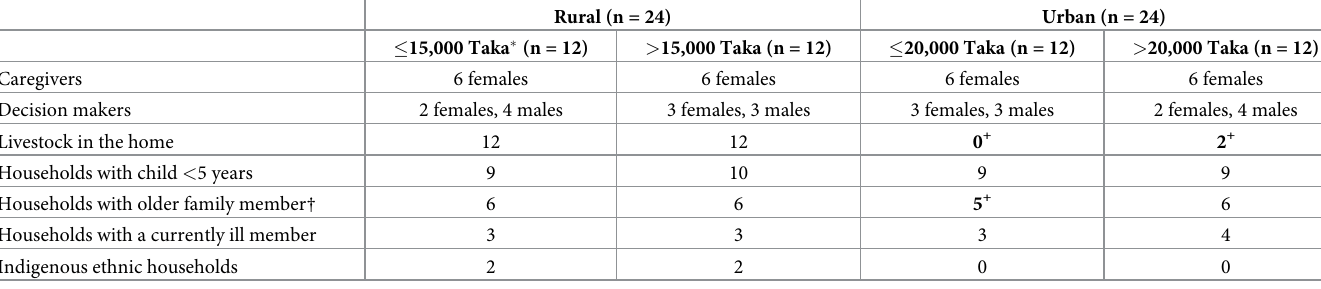
Table 1. Household interviews: Characteristics of